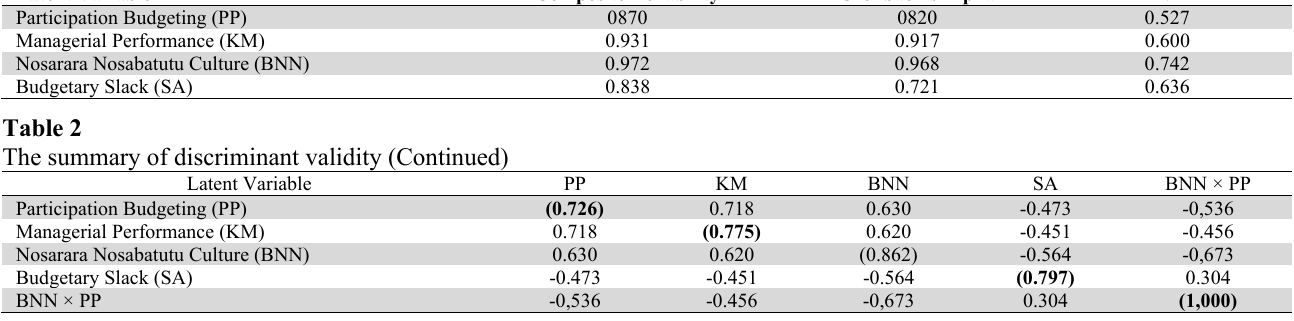
Table 2 present the results of composite reliability, Cronbach Alpha and AVE for all components of the survey. The summary of reliability and validity Latent Variable